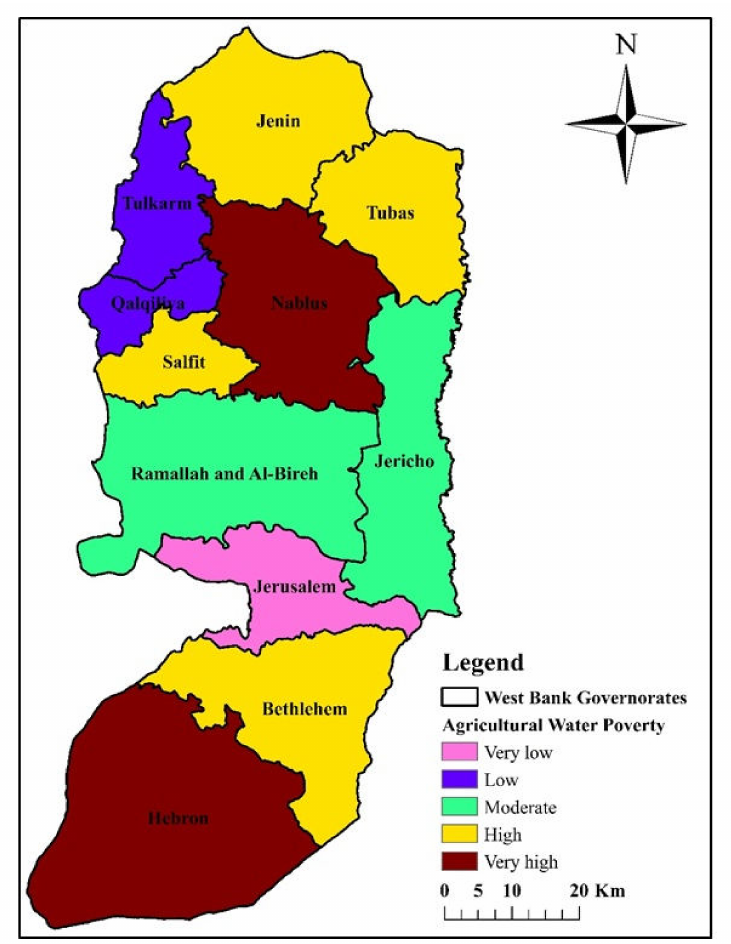
Figure 5. AWP map for the West Bank case